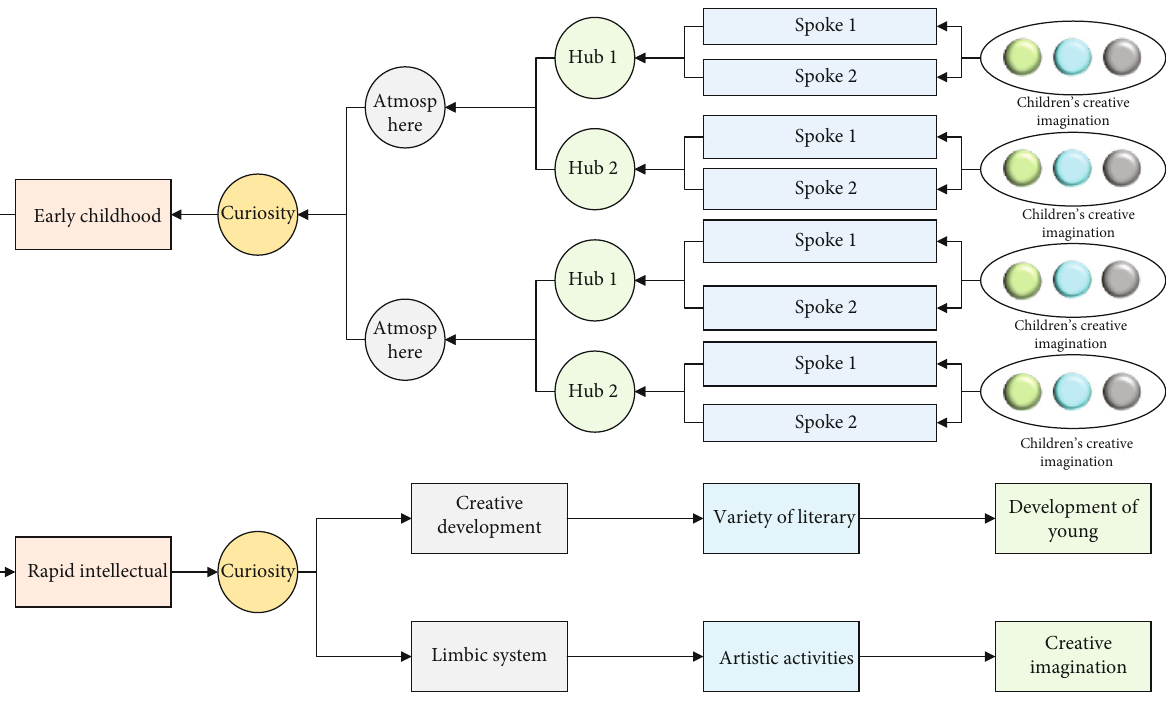
Figure 2: Virtual-aided design framework.